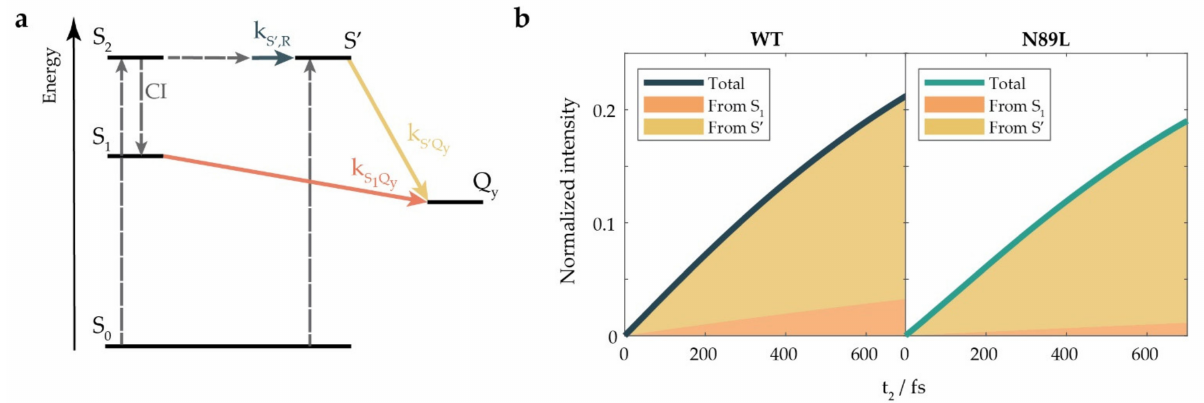
Figure 5. ( a ) Energy level diagram illustrating the different dynamic processes included in the kinetic model used to interpret the temporal dynamics of the experimental traces. Dashed lines indicate events occurring on a time scale faster or comparable with the time resolution of the experiment, namely, the initial optical excitation and the decay of the S 2 state via (i) the CI that transferred the population from S 2 to S 1 and (ii) the initial torsional movements that promoted the formation of distorted structures. k S (cid:48) , R , k S , and k S (cid:48) Q represent the kinetic constants for the rise of S’, the y 1 Q y S 1 /ICT → Q y ET, and the S’ → Q y ET, respectively. ( b ) Contributions to the rise of the ET signal, as determined by the fitting of the experimental data using the kinetic model in panel ( a